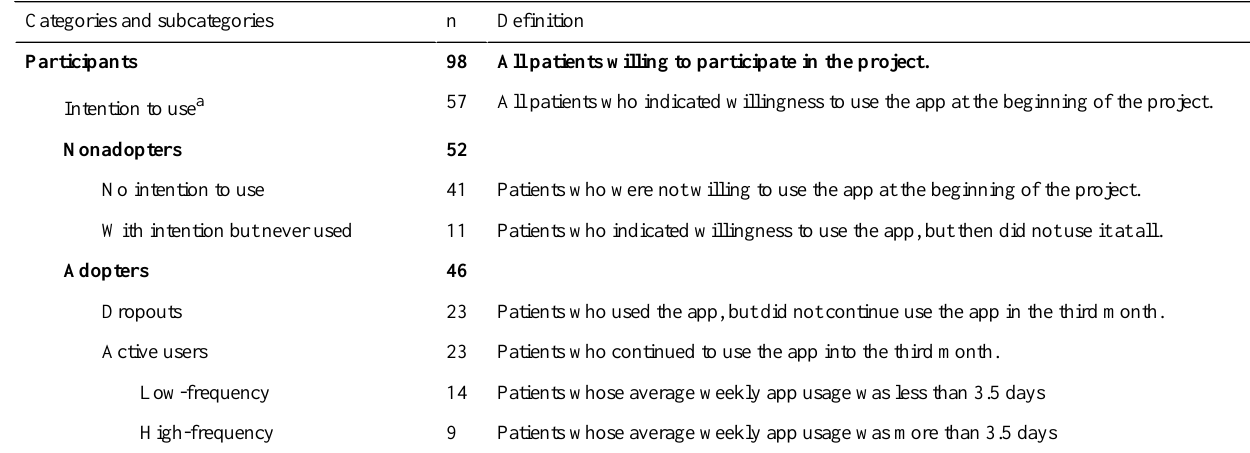
Table 1. Definitions of participant